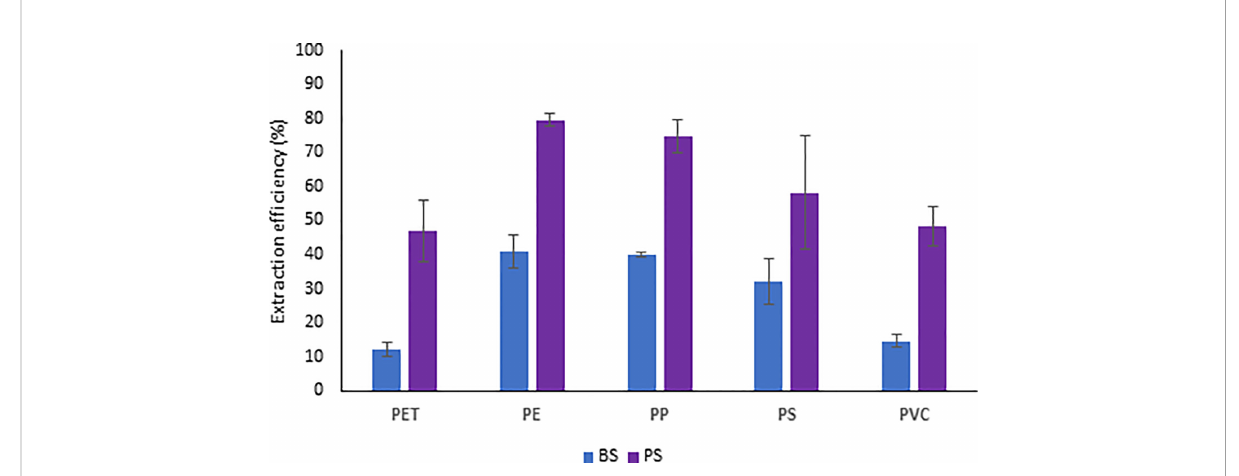
FIGURE 3 Extraction ef fi ciency of microplastics (20-1000 µm) from deep-sea sediments based on two different approaches applied to bulk (BS) and partitioned (PS)